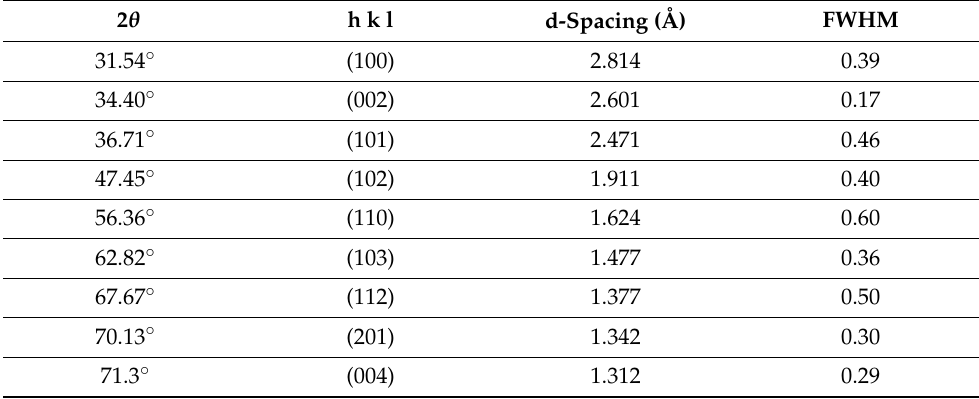
Figure 5. Graphs of normal residuals, ( a ) percent vs. residual, ( b ) fitted value vs. residual, ( c ) frequency vs. residual and ( d ) residual vs. observation order. Table 3. XRD parameters of ZnO after five coating